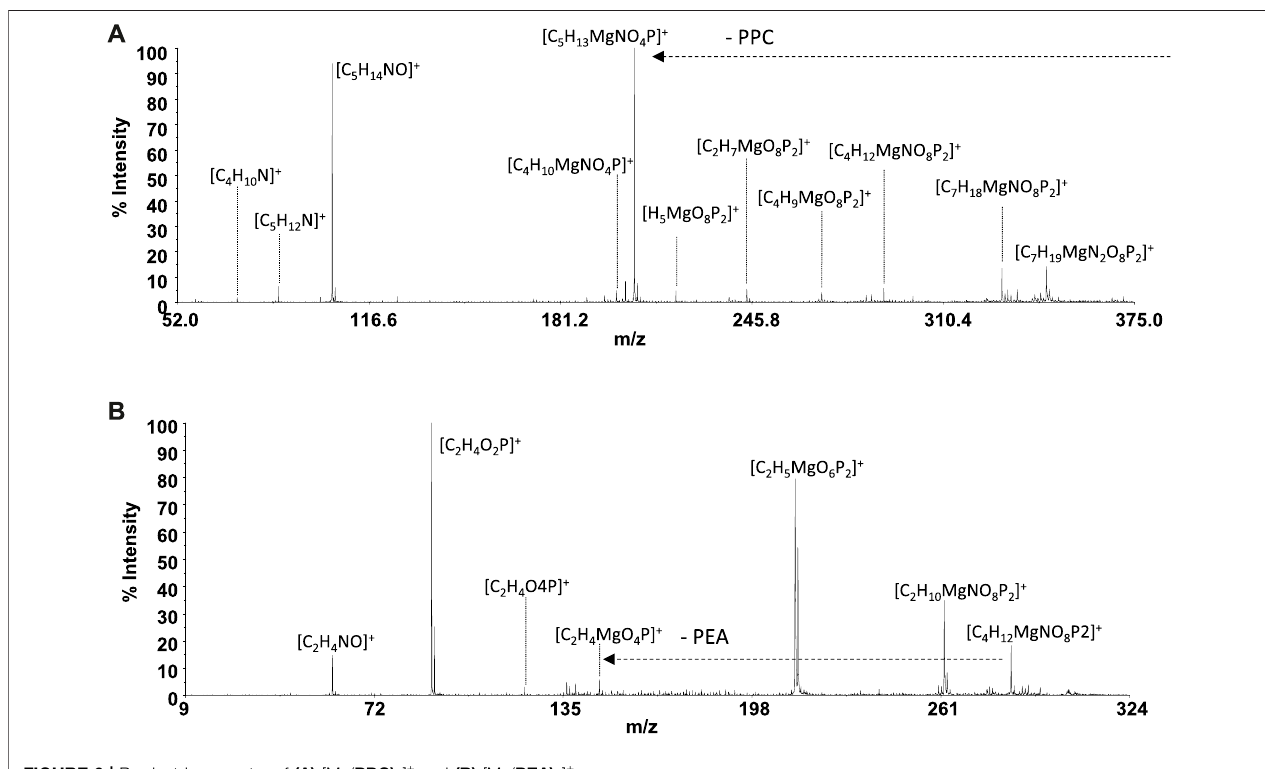
FIGURE 9 | Product-ion spectra of (A) [Mg( PPC) 2 ] + and (B) [Mg( PEA) 2 ] + .